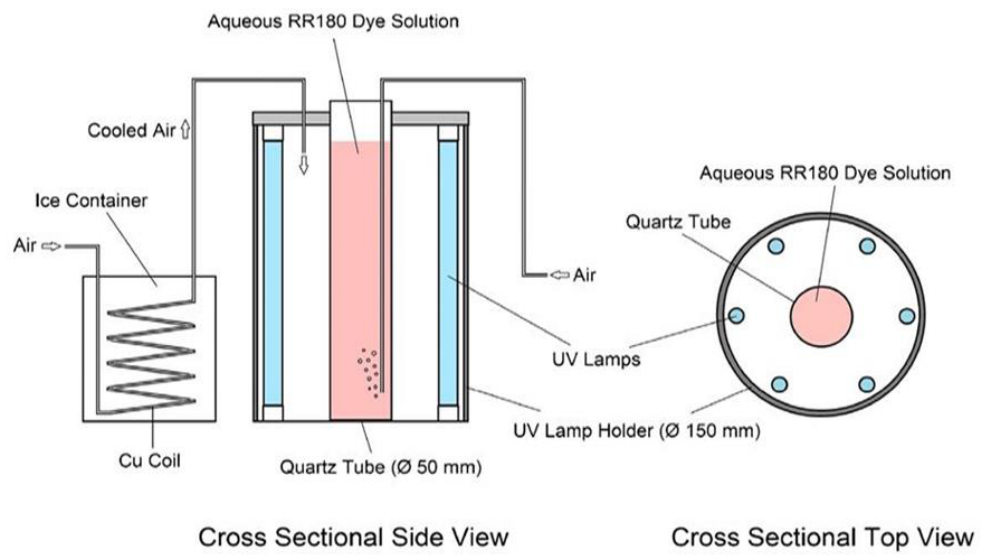
Figure 2. The schematic diagram of the photocatalytic reactor.